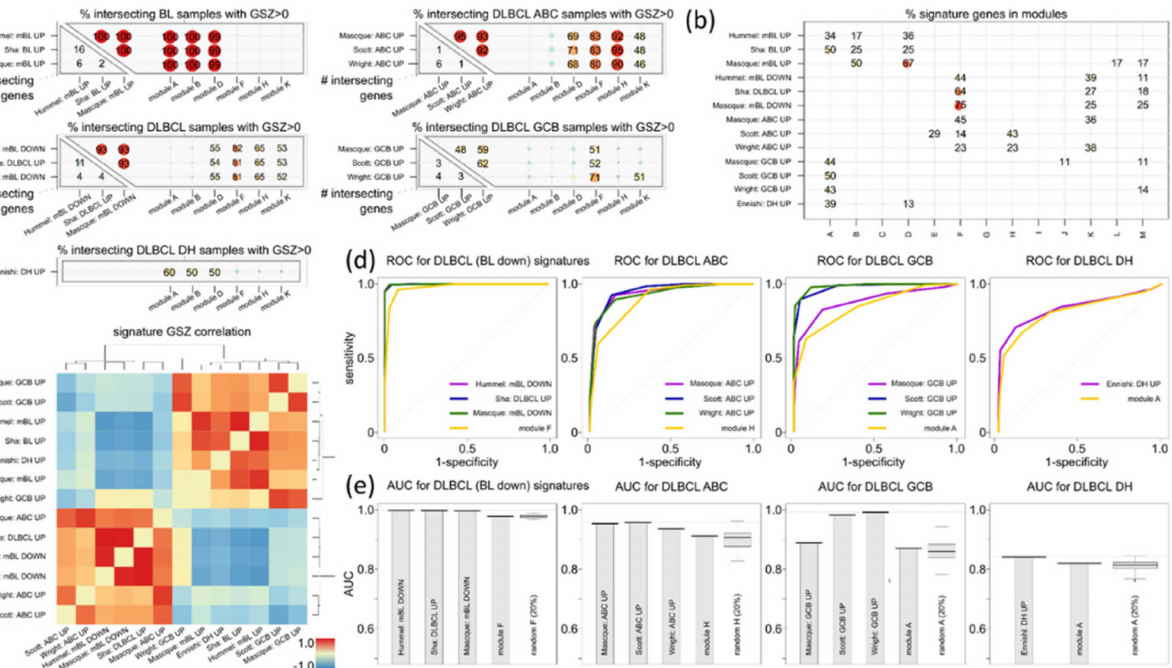
Figure 7. Distinguishing lymphoma subtypes: ( a ) Mutual overlap matrices of signature genes (left- lower part of the matrices) and of samples with GSZ > 0 for literature signatures and spot modules (right part of matrices) of BL_up, DLBCL_up, ABC_up, GCB_up and DHL_up reflect different discrimination power of the spots (see Figures A9 and A11 for details on ABC-versus-GCB and DHL analyses). For example, “proliferation” spot D identifies BL, but also DLBCL in non-negligible amounts. Spot F, in turn, detects DLBCL but not BL. See also Figures A3 and A7 for an overview. ( b ) Overlap of signature genes (rows, see vertical axis) with genes collected in the modules